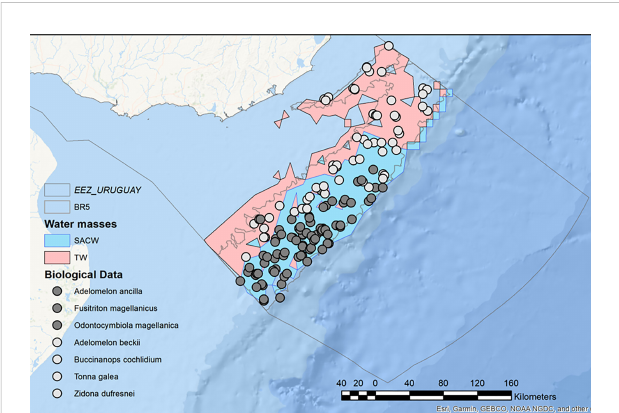
FIGURE 4 Detail of Benthic Region 5 (BR5, Deep Oceanic Sublittoral) for the Uruguayan EEZ, highlighting the existence of two different benthic assemblages associated with contrasting water masses.